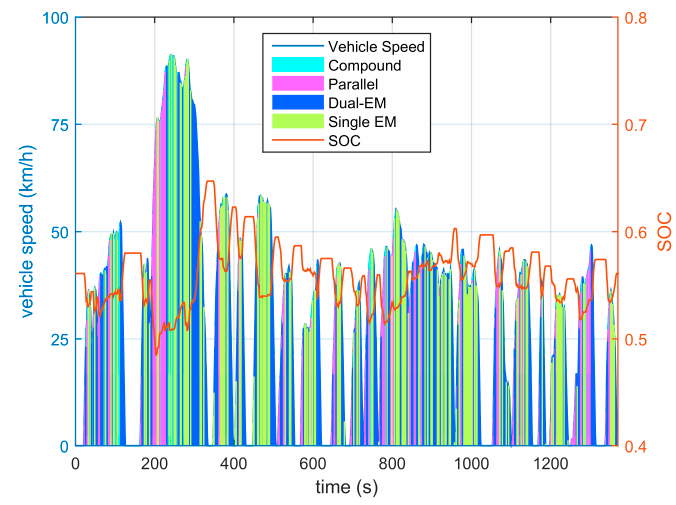
Figure7. SOC trajectory and mode selection of fuel only ( α = 0) over the UDDS cycle.